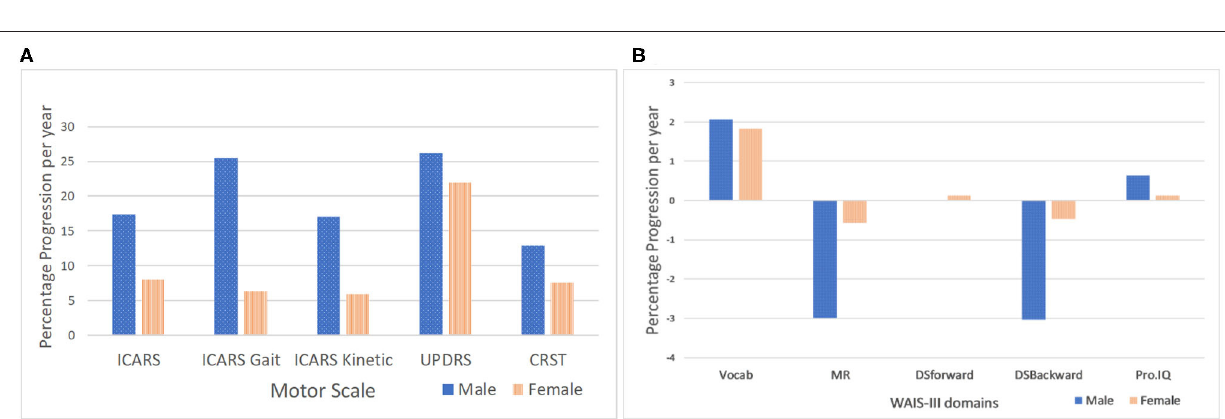
FIGURE 3 | Male-female differences in the rate of progression per year in motor scores adjusted for T1 scores. (A) P values are for statistically significant differences between males and females for rate of progression (* t -test for unequal variances). P values for T2-T1 measures (male-female differences) adjusted for T1 scores: ICARS total ( p = 0.029); ICARS Gait ( p = 0.013); ICARS Kinetic ( p = 0.026*); CSRT and UPDRS ( p > 0.05)- P values for T2-T1 measures (male-female differences) not adjusted for T1 scores: ICARS total ( p = 0.003*); ICARS Gait ( p = 0.02*); ICARS Kinetic ( p = 0.008*); and CSRT ( p = 0.000*); UPDRS ( p > 0.05). Male-female differences in the rate of progression per year in WAIS-III scores adjusted for T1 scores. (B) Males did not progress significantly in any Wechsler subscale scores or in Prorated IQ between T1 and T2. Females only showed (marginally) significant improvement in the Vocabulary subscale ( p =